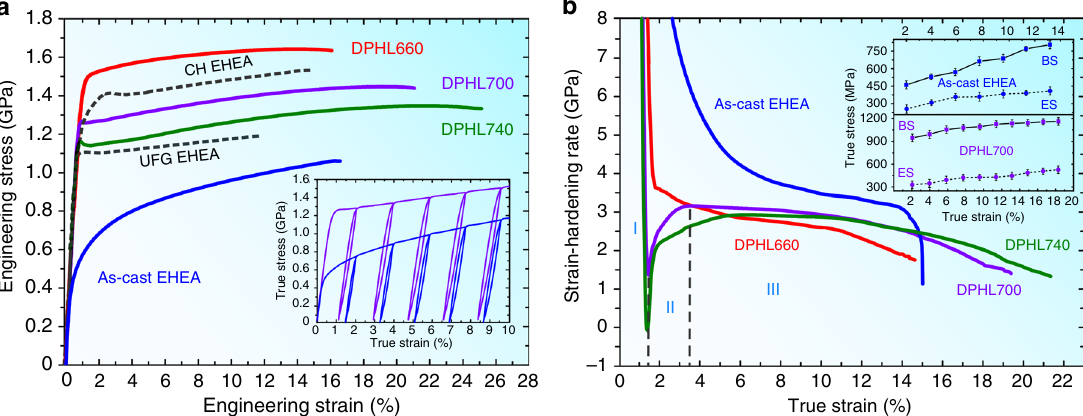
Fig. 2 Mechanical responses of the three DPHL HEAs at room temperature. a Tensile properties. UFG EHEA and CH EHEA refer to the ultra fi ne-grained EHEA 7 , and the complex and hierarchical EHEA 23 , respectively. The inset is the loading – unloading – reloading behavior of the DPHL700 and the as-cast EHEA (whole curves exhibited in Supplementary Fig. 3). b Strain-hardening response. As a representative, the multistage stress – strain relationships are marked as I – III in DPHL700. The inset shows the back-stress (BS) and effective-stress (ES) evolution with the plastic strain for the as-cast EHEA and DPHL700. Error bars in the inset indicate standard deviations for fi ve tests